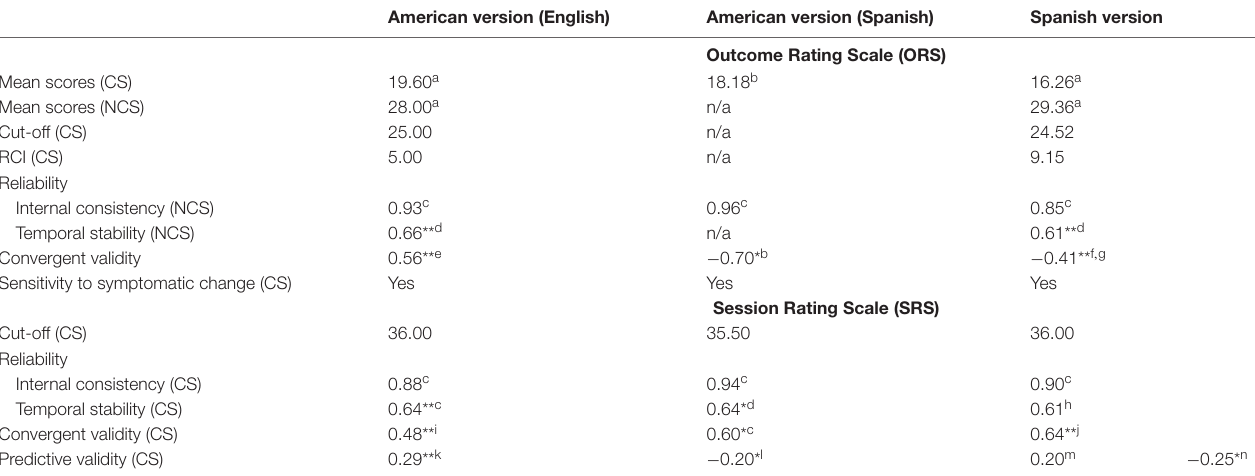
TABLE 4 | Comparison of the main results of the English and the Spanish versions of the Outcome Rating Scale (ORS) and the Session Rating Scale